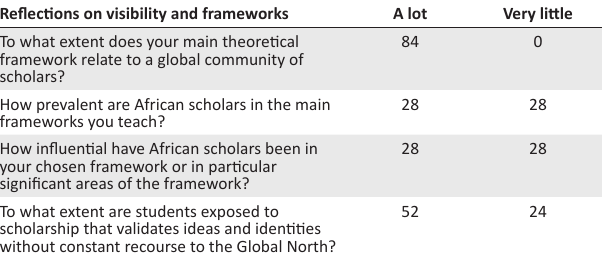
TABLE 4: Level of representation of local and diverse epistemologies in the curriculum in percent of